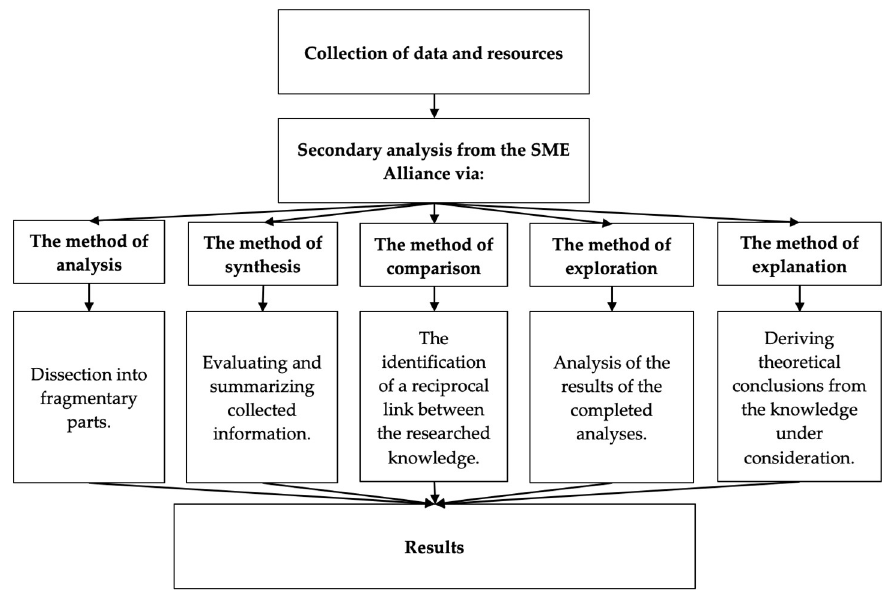
Figure 2. Diagram depicting the methodology employed in this investigation. Source: Authors’ compilation, according to [60].